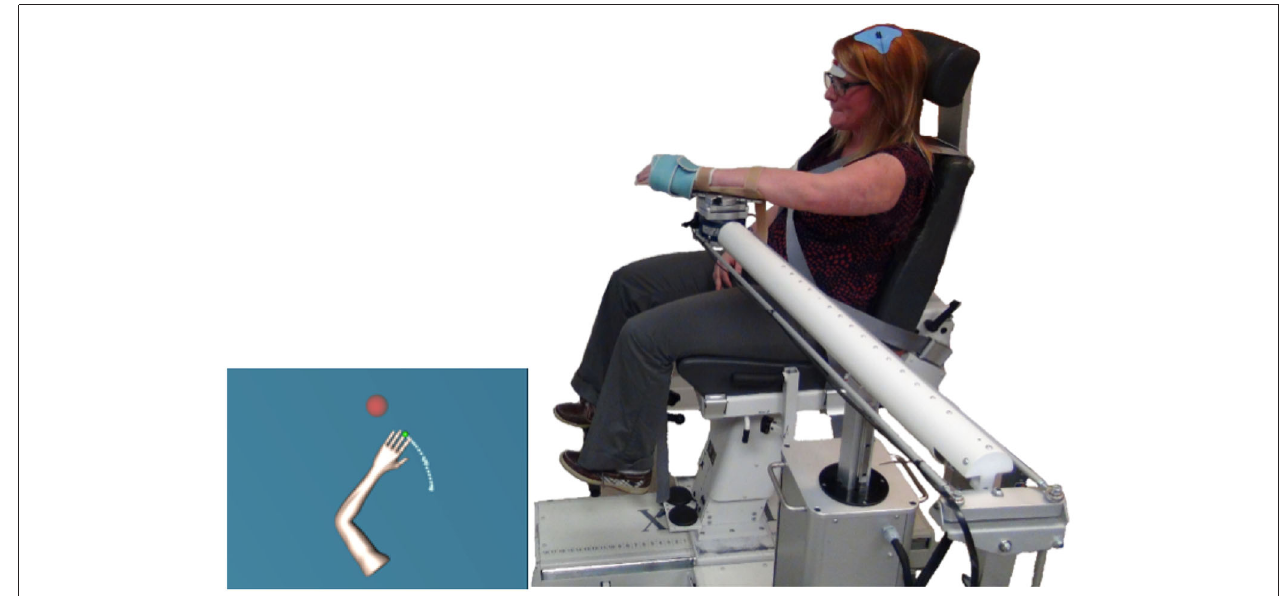
FIGURE 1 | ACT3D robot setup. On the left, it shows the visual feedback provided to the participant. On the right, it shows the ACT3D robot setup and the c-tDCS